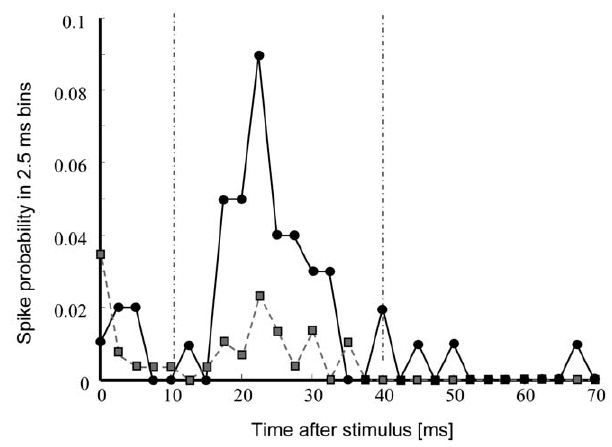
Figure 3. Effect of training protocol on the post stimulus time histogram (responsiveness) of the evaluation electrode. Dashed (gray, & ) line shows the probability to record an action potential at a selected evaluation electrode during the first 10 stimuli of the training protocol. The time interval to determine the ‘responsiveness’ (the fraction of stimuli that yielded at least one action potential in this interval) was set at 10–40 ms (dash-dotted lines), such that the summed probability before training was about 0.1. Solid (black, probability during the last 10 stimuli of the training protocol.